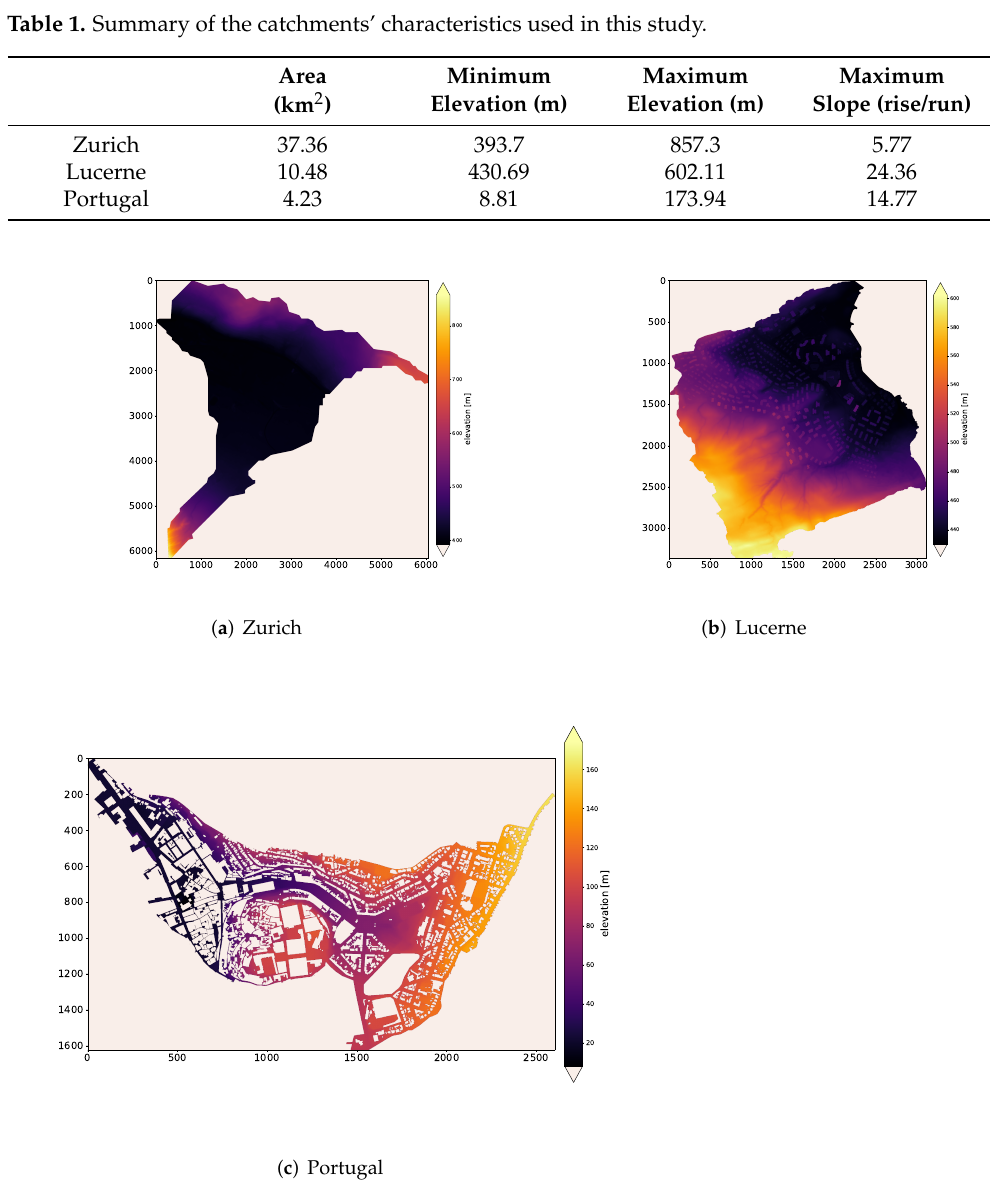
Figure 2. Illustration of the Zurich, Lucerne, and Portugal catchments in our dataset. The colour represents the terrain elevation data for the